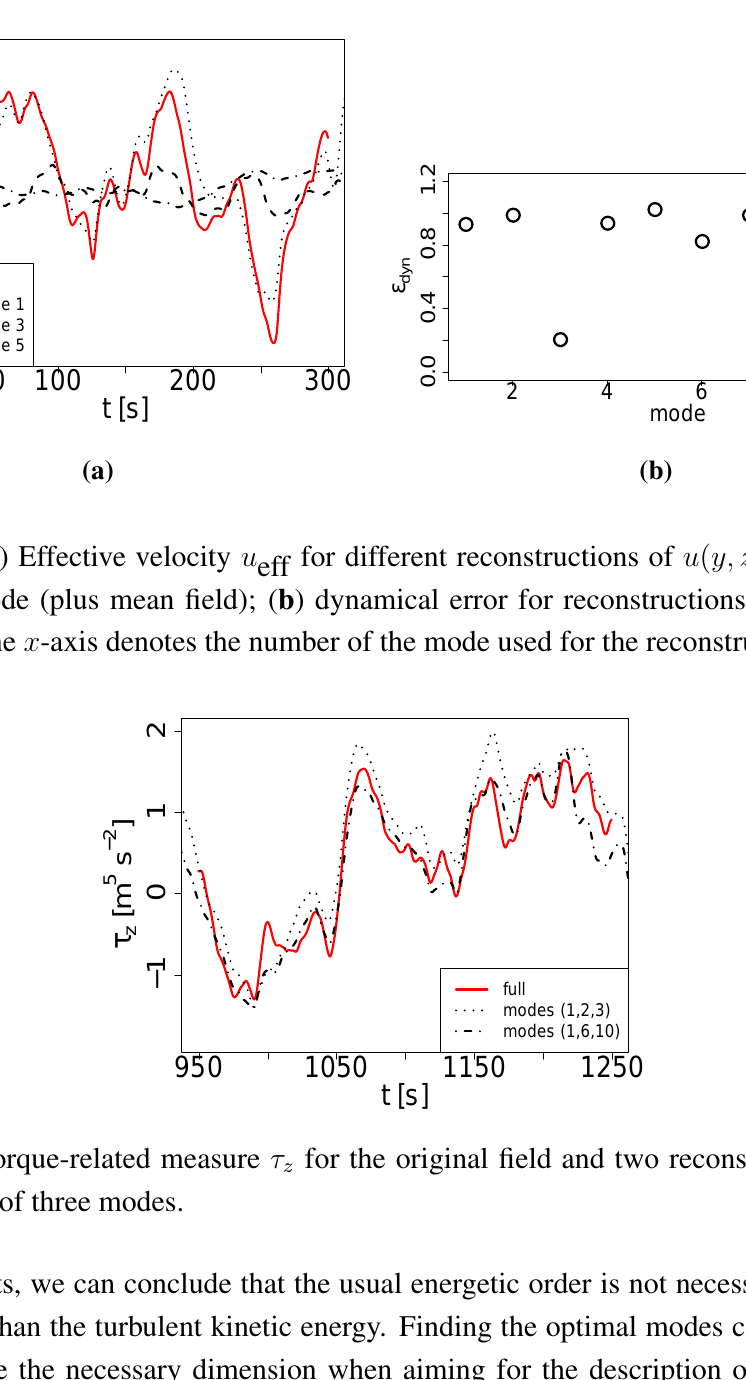
for the original field and two reconstructions using z